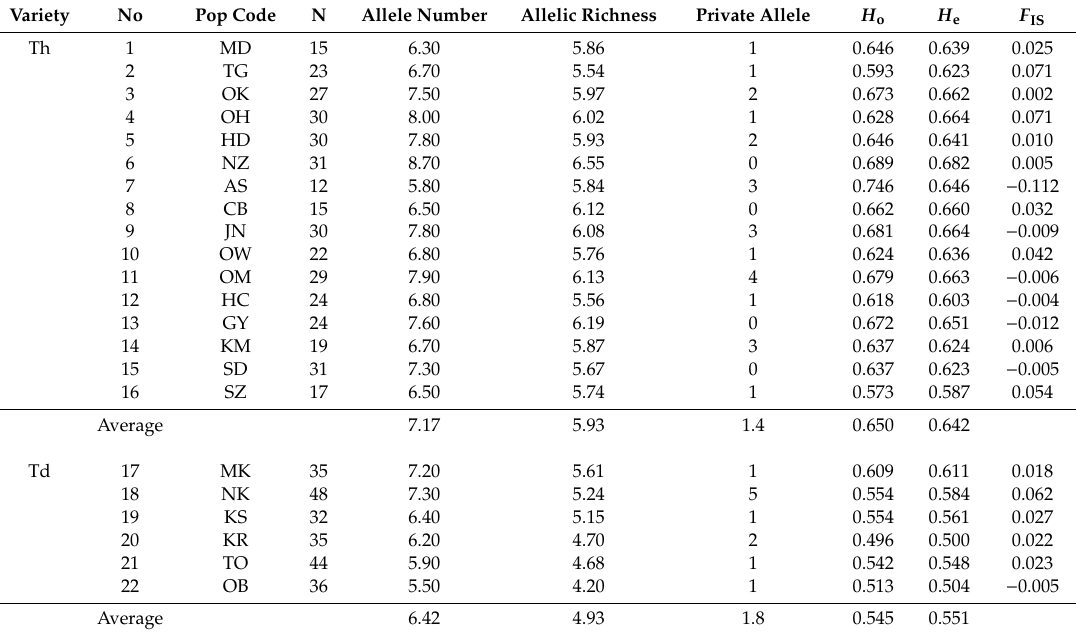
Table 2. Genetic diversity measures estimated at 19 microsatellite